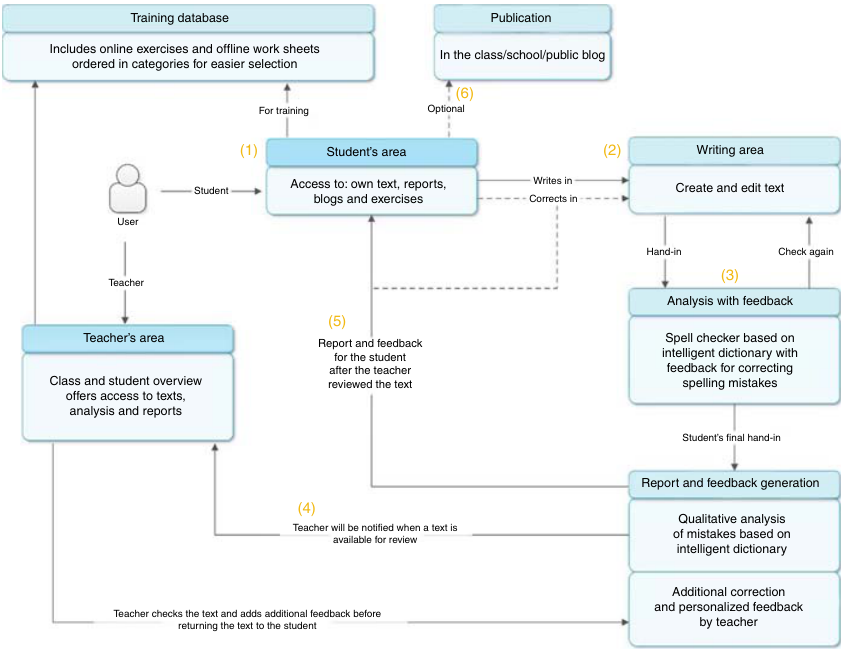
Figure 1. Workflow of the IDeRBlog